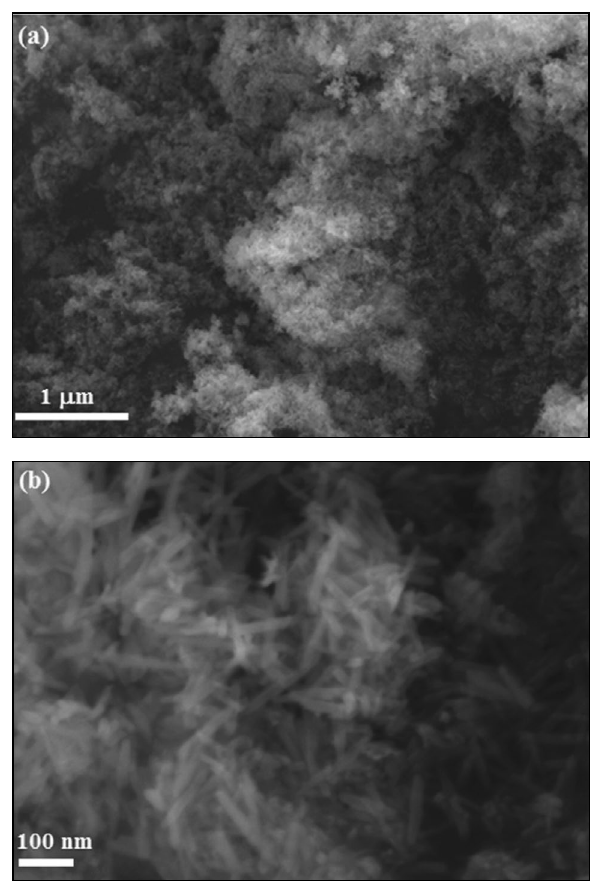
Fig. 5. Raman spectrum of the NdVO 4 nanoparticles prepared in this